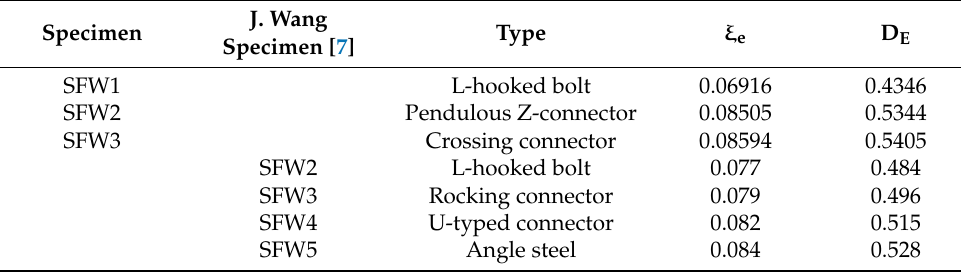
Table 7. Comparison of the energy dissipation parameters of specimens at ultimate